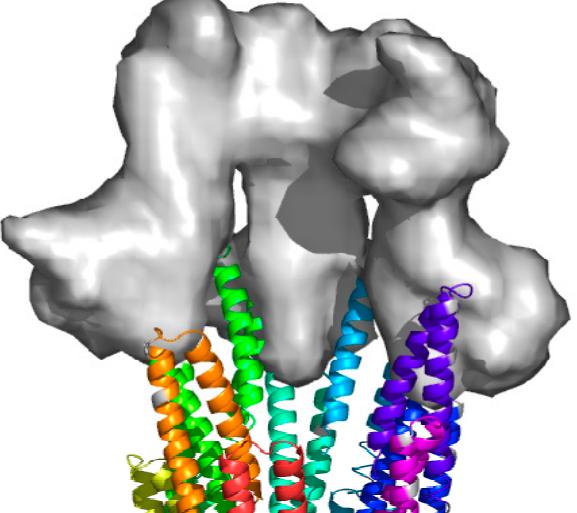
Figure 1. Model of the tip protein complex at top of the injectisome needle. A rendered model of three of the five subunits of the Yersina SctA tip complex protein is shown interfaced with an assembled model of the SctF needle based upon the crystal structure of MxiH (PDB-2CA5). Adapted with permission from [30], PNAS, 2006.